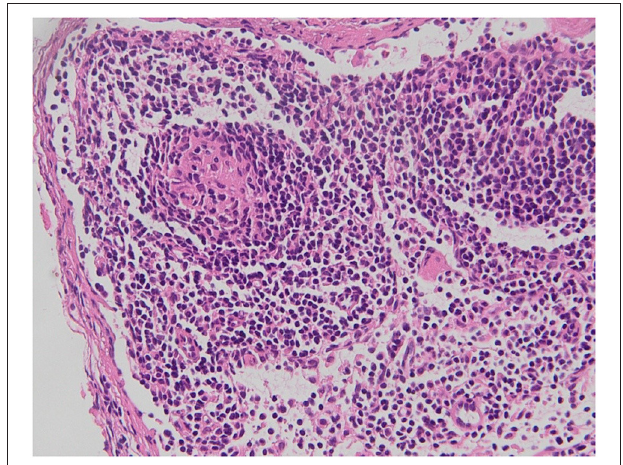
FIGURE 4 | Histology of mesenteric leaves interested by intense chronic inflammation.